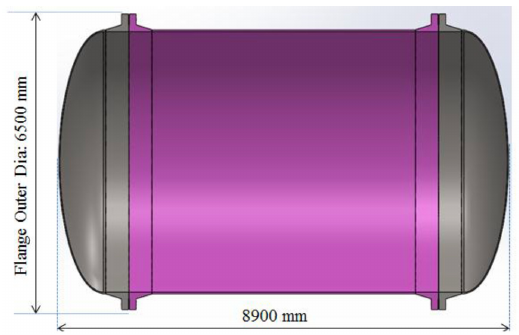
Figure 46. Pressure vessel preliminary